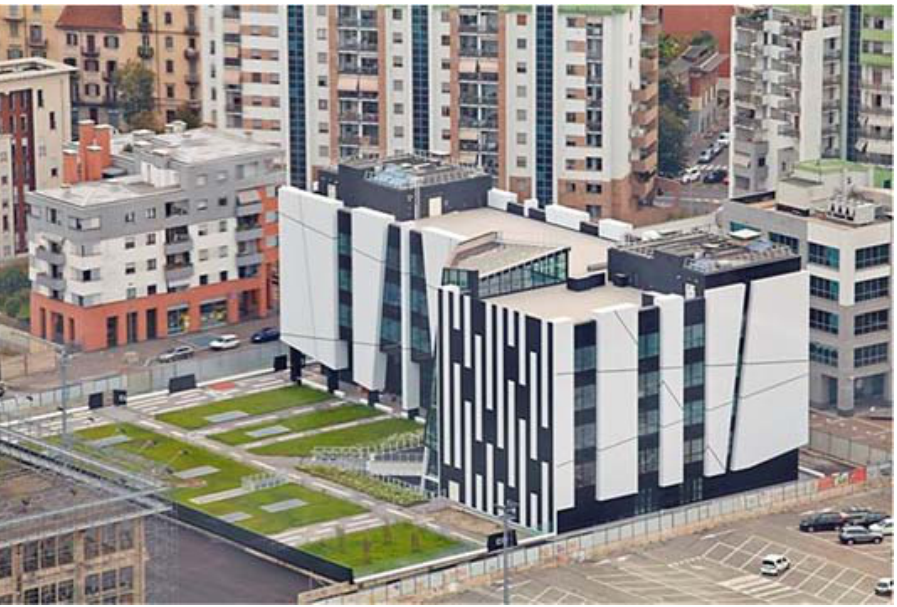
Figure 1. Energy Center, the target building. Photo source: https://mattioda.it/en/cantieri/energy- center-torino-to/ (accessed on 1 June 2022).